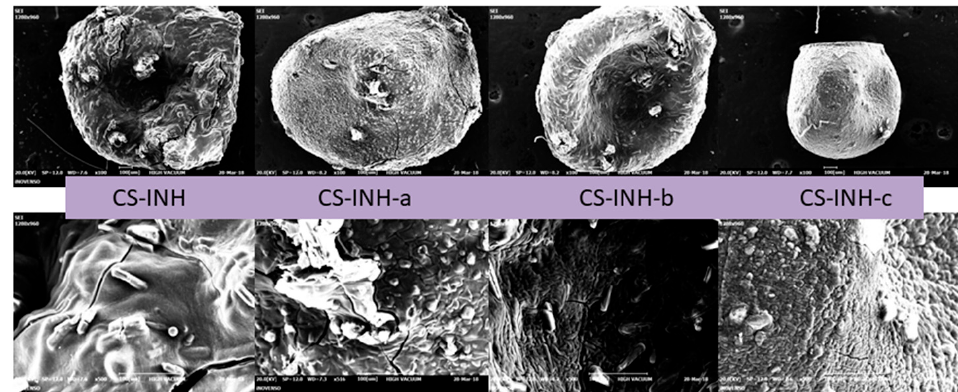
Figure 5. SEM image of chitosan microparticles containing active substances (CS – INH, CS – INH-a, CS – INH-b and CS – INH-c).